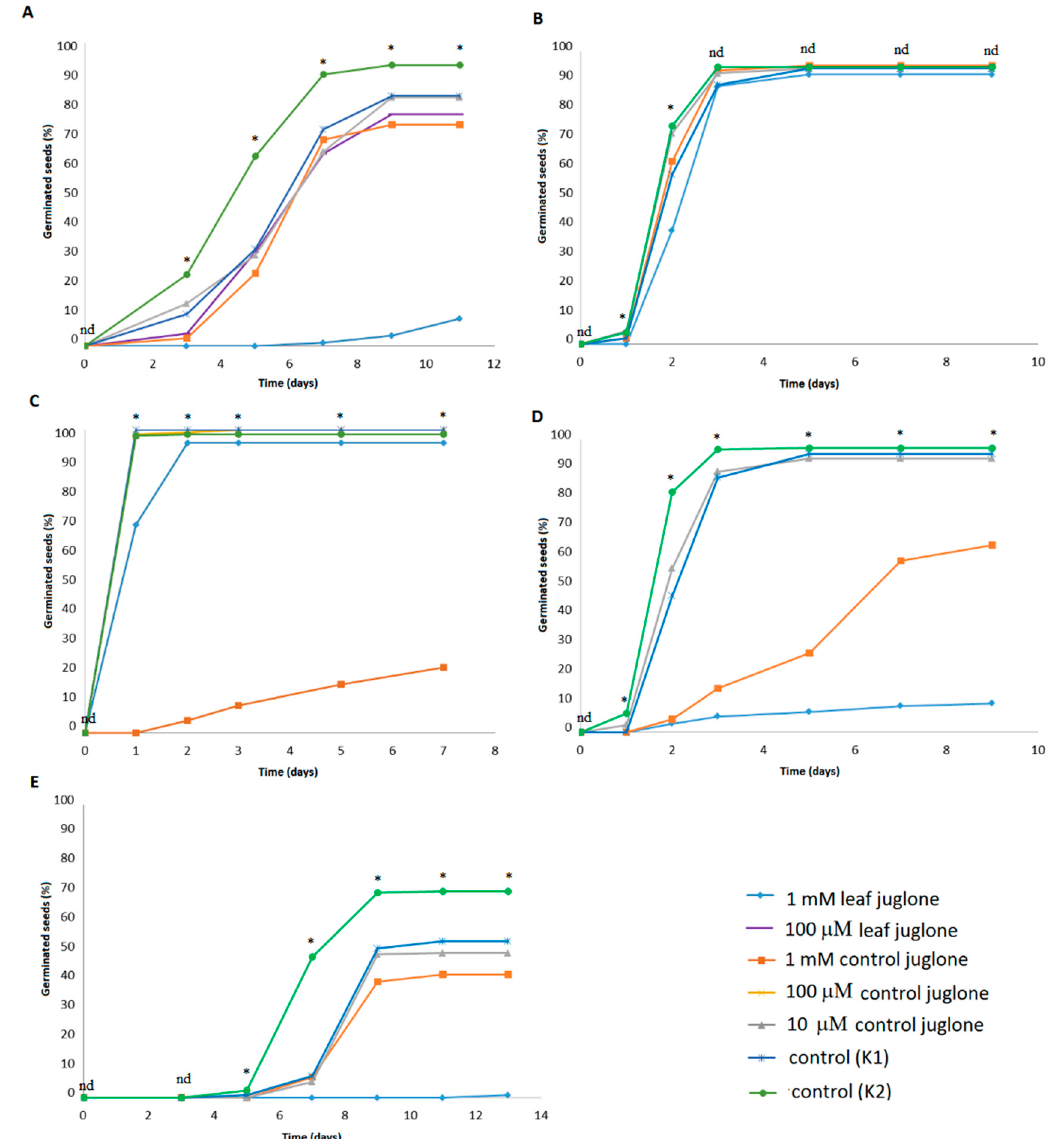
Figure 1. Effects of control juglone and known leaf extract juglone treatments on germination of seeds of S. lycopersicum ( A ), L. culinaris ( B ), L. sativa ( C ), B. rapa var. japonica ( D ) and V. locusta ( E ). K1, extraction medium (vehicle); K2, water; *; are significantly different ( p < 0.05); nd, not significantly different.